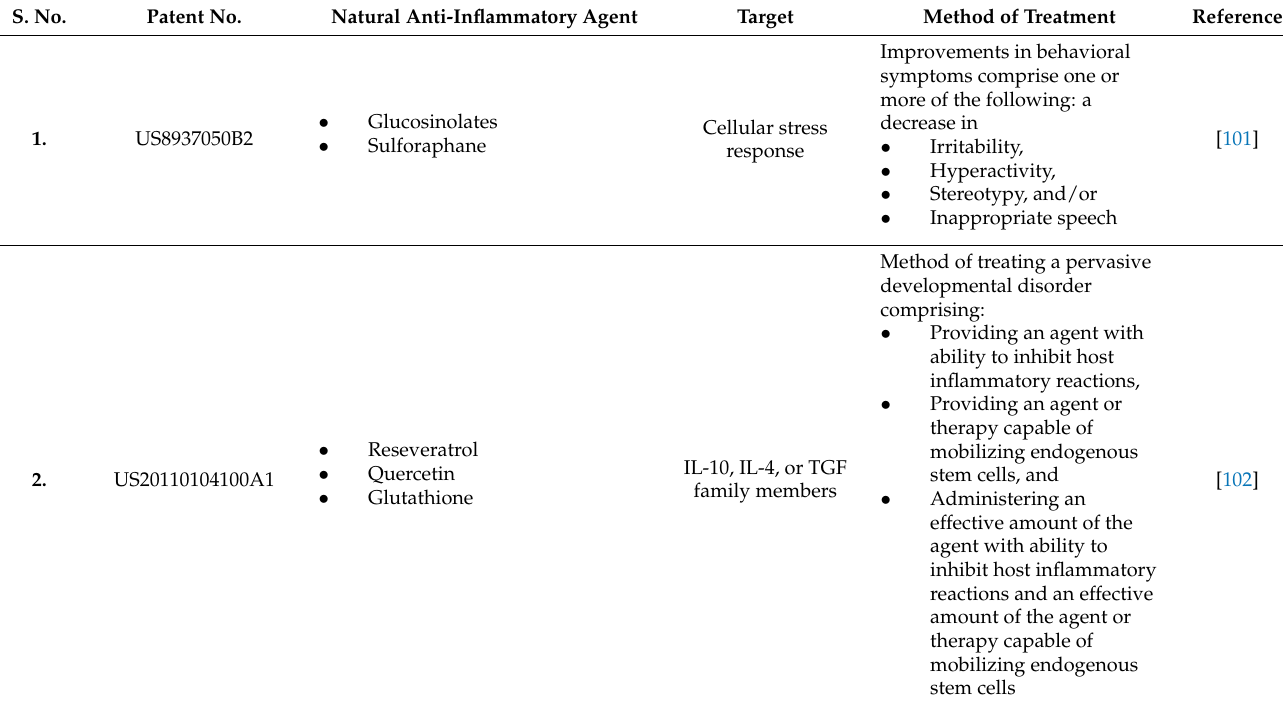
Table 3. Summary of translational studies of natural anti-inflammatory agents targeting inflammatory